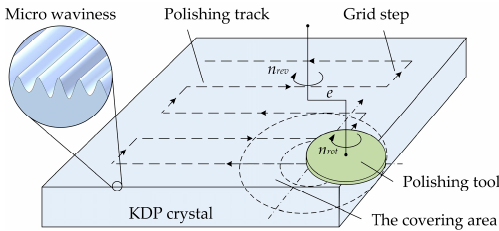
Figure 1. Schematic of the ultra-precision polishing principle with CCOS technology for removing the diamond turned micro-waviness.